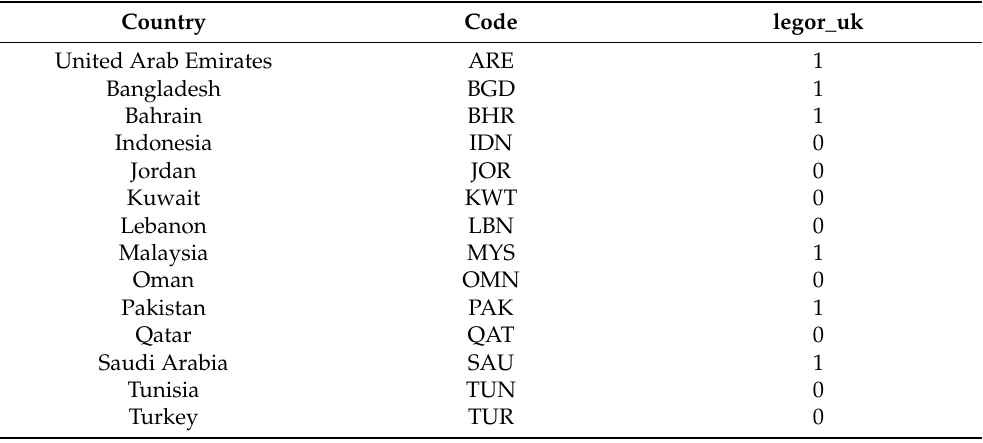
Table 6. Legal Origin Dummy.